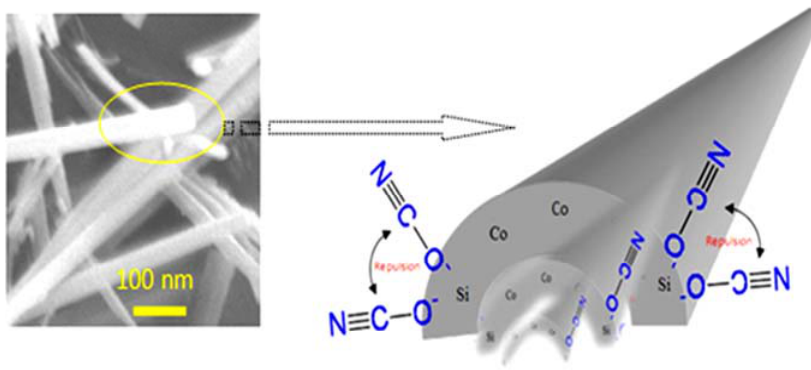
Figure 6. Schematic representation of 1D nanofiber.